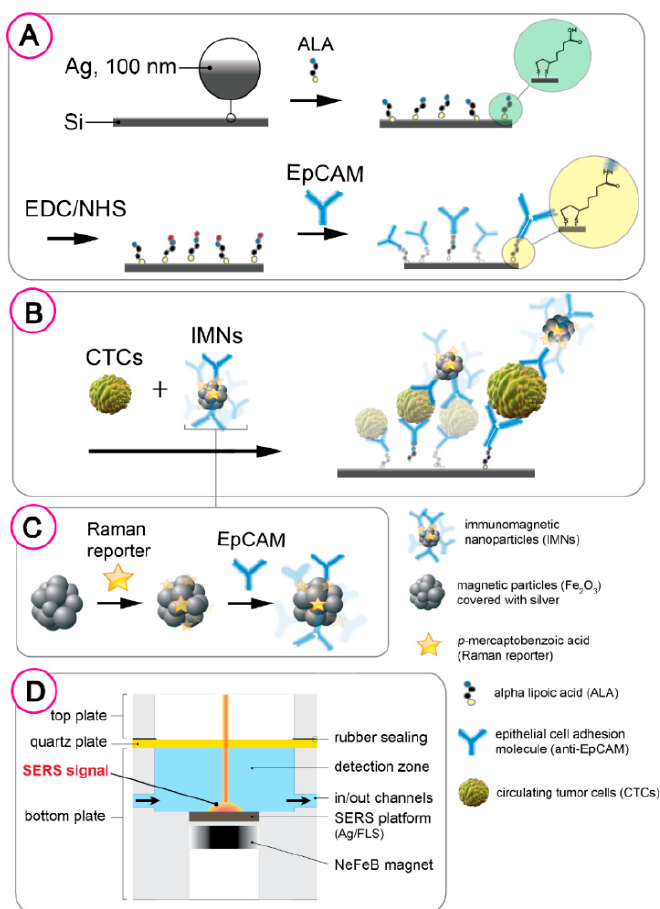
Figure 2. Structure of magnetically-supported surface-enhanced Raman spectroscopy (SERS)-based analysis of CTCs. ( A ) SERS platform modification with folic acid. ( B ) Anti-EpCAM antibodies capturing on the modified SERS platform via EDC/NHS (1-ethylo-3-(3-dimethyloaminopropyl)carbodiimide/hydroxysulfosuccinimide) strategy. ( C ) Addition of target CTC and Raman reporter-labeled–immune-magnetic nanoparticles to form immunocomplexes. ( D ) Detection zone (DZ) chamber.